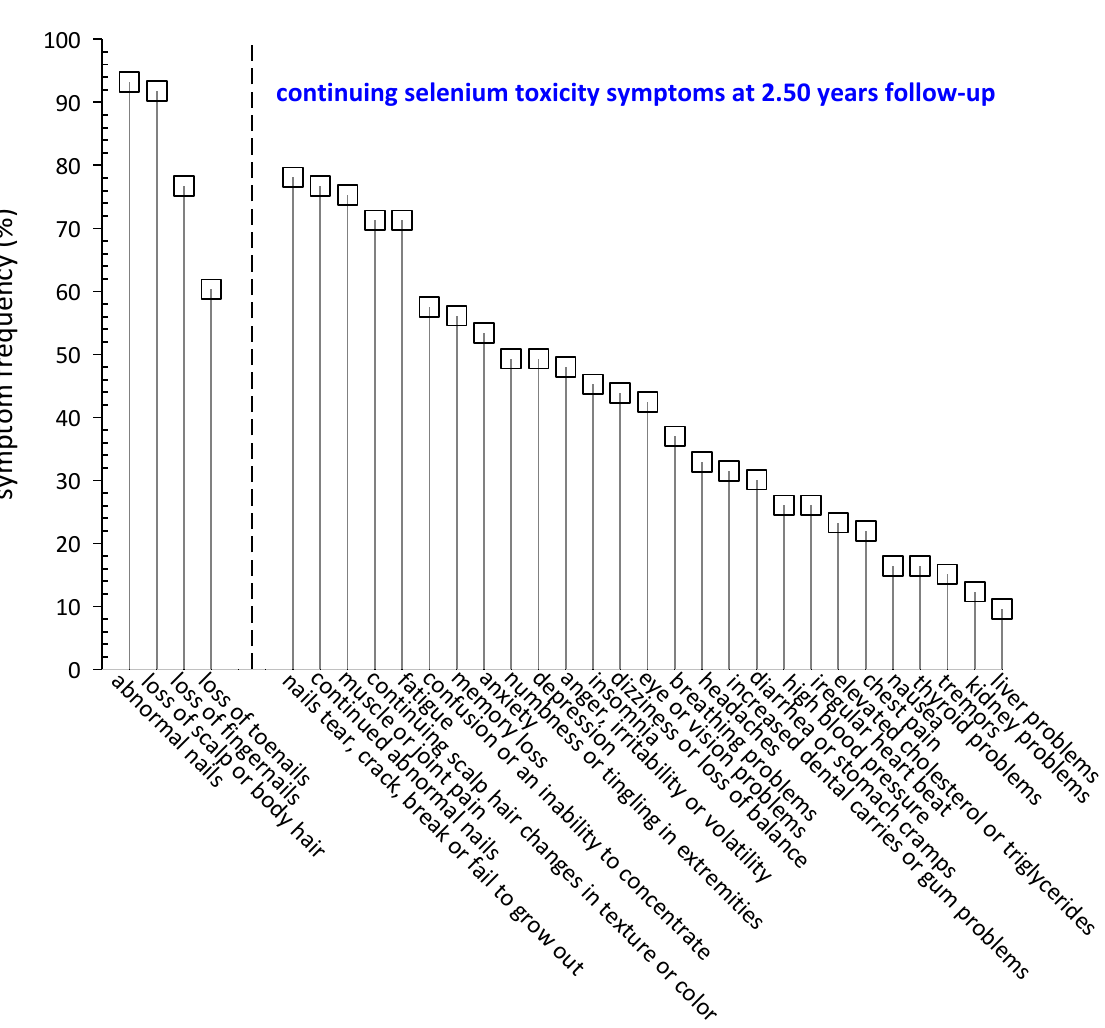
Of these 73 subjects, 93.2% initially reported abnormal nails, 76.7% loss of FNs (mean = 9.6 ± 1.6; median = 10 FNs), 60.3% loss of TNs (mean = 6.5 ± 3.7; median = 8 TNs), and 91.8% loss of scalp or body hair. Respondents reported 1 to 27 persistent symptoms (mean = 11.5 ± 6.5; median = 10 symptoms) that they attributed to their use of the misformulated TBF products and the resulting Se intoxication. Other than hair and nails, the most frequently reported persistent symptoms were muscle or joint pain (75.3%), fatigue (71.2%), and numerous adverse neurological symptoms (~50%). For more detail, see Figure 6. Sixty-three subjects responded to the categorical question regarding disposition of symptoms at 2.5 years with 36 (57.1%) reporting symptoms improving, 21 (33.3%) symptoms the same, and 6 (9.5%) symptoms getting worse. Subjects reporting improving symptoms also reported